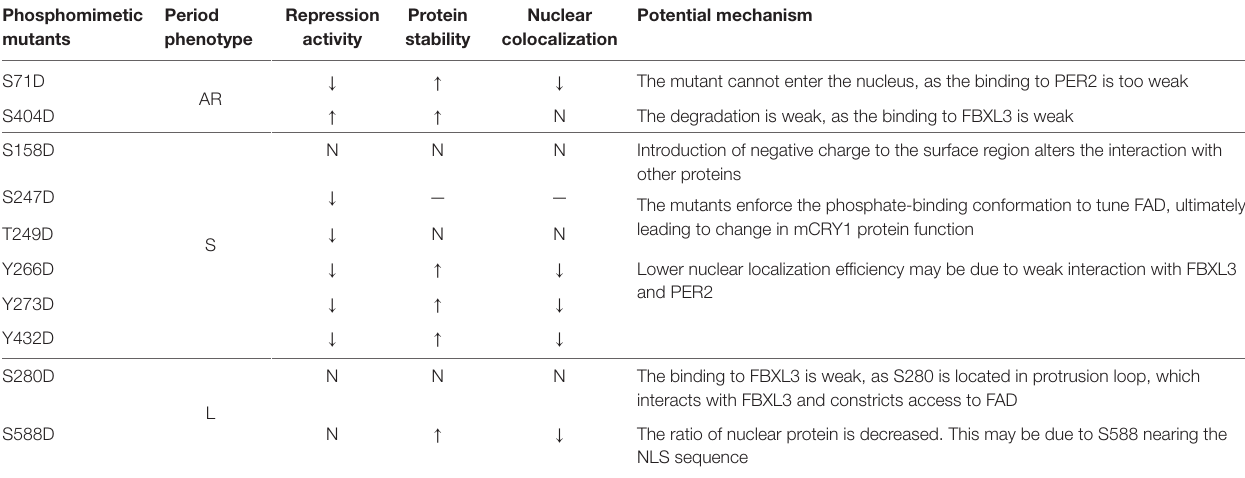
TaBle 2 | Phosphorylation regulating the ratio of intracellular mcrY1 determines the circadian period length by different